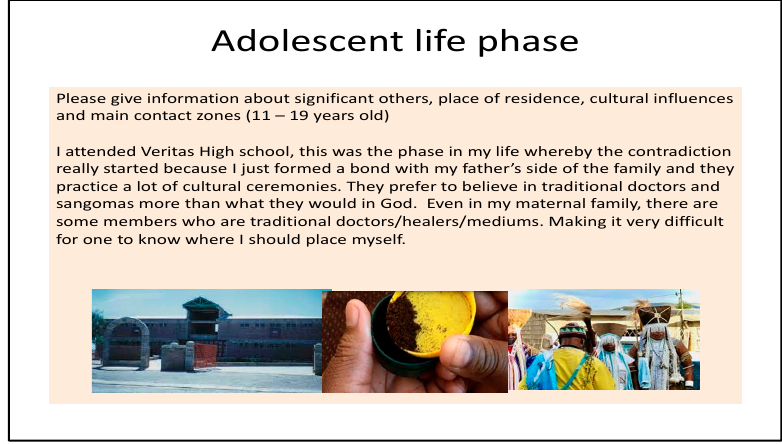
Figure 3. Lihile’s adolescent life phase.